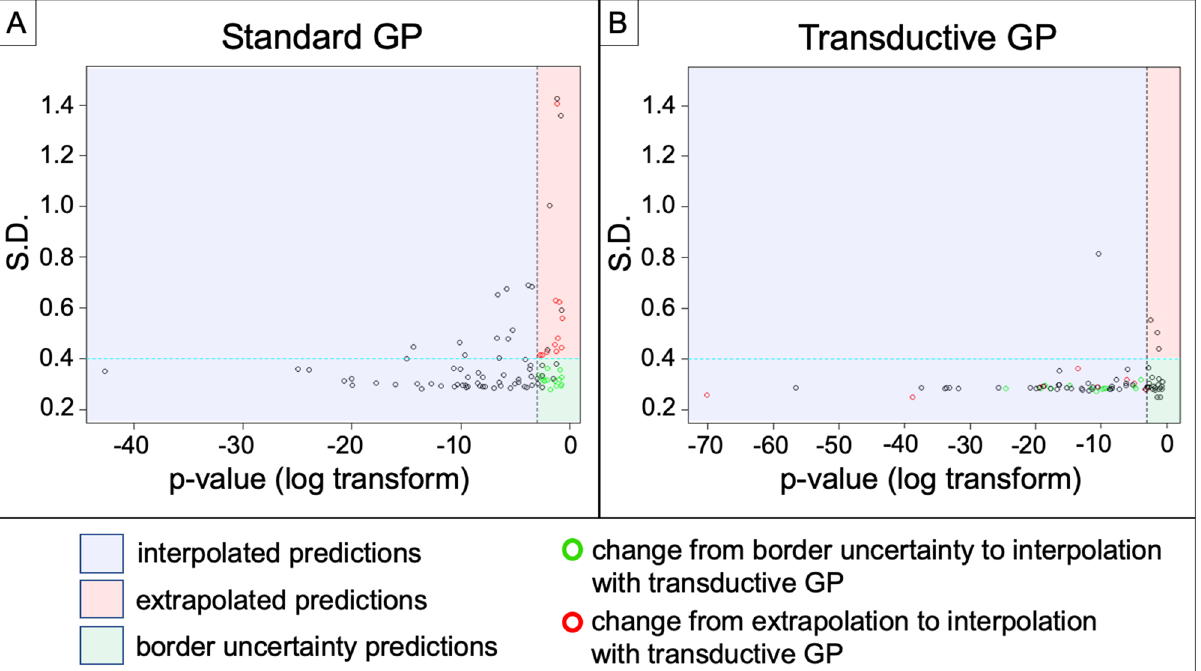
Figure 2. Transductive learning GP increases the number of interpolated sample predictions compared to standard GP. Shown are scatter plots of standard deviation (S.D.) (y-axis) versus log-transform of p value (x-axis) for all 95 sample predictions by the (A) Standard GP and (B) Transductive Learning GP models. The blue region demarcates those samples with p < 0.05 (log transform < − 3) corresponding to interpolated predictions. The red region demarcates extrapolated predictions (p > 0.05, SD > 0.40), while the green region demarcates predictions with border uncertainty (p > 0.05, SD < 0.40). The green circles denote those samples that shifted from border uncertainty to interpolated predictions with transductive learning. Similarly, the red circles denote those samples that shifted from extrapolated to interpolated predictions with transductive learning. Transductive GP produced 72/95 interpolated sample predictions, compared with 58/95 for Standard GP. Note the substantial decrease in extrapolated predictions with the transductive learning GP